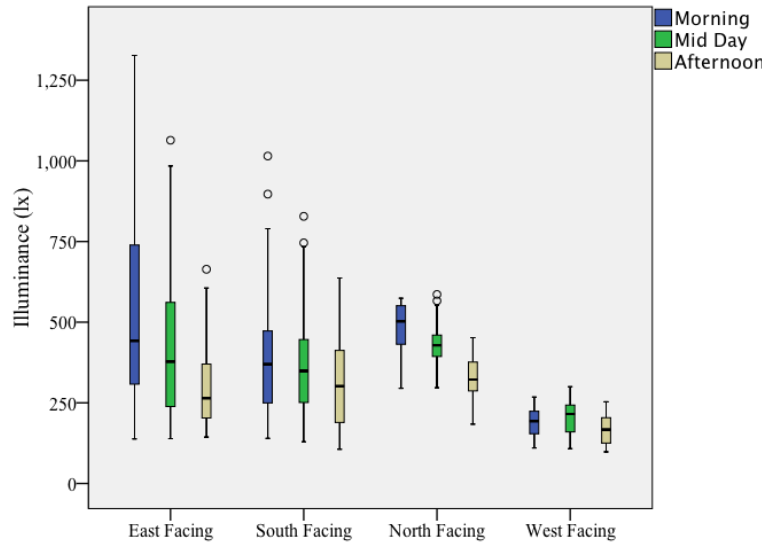
Figure 3. Desktop Illuminance for workstations with different orientations.